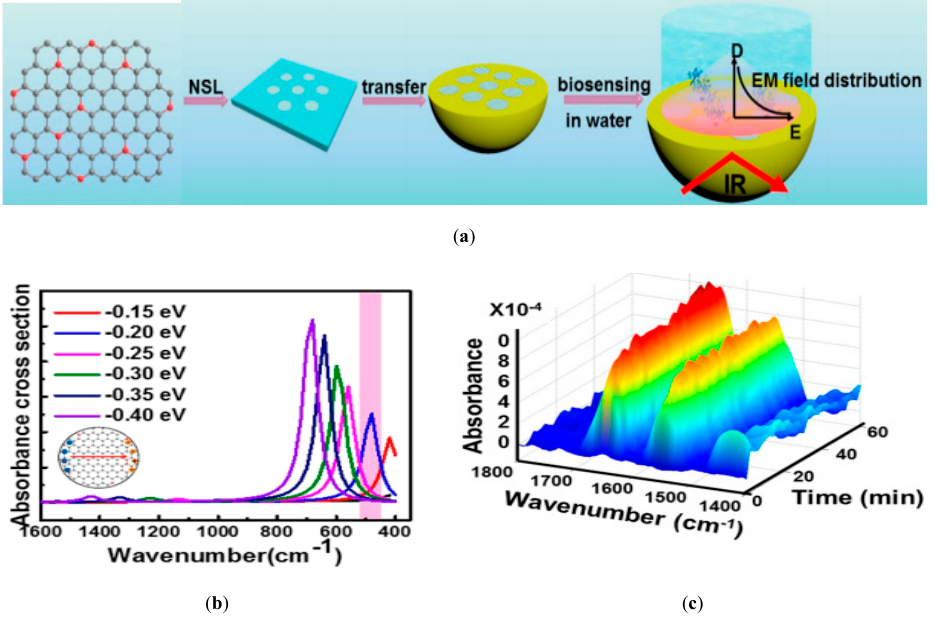
Figure 22. ( a) Schematic illustration of a graphene-based biosensor in the IR range; ( b ) Resonance tuning of the sensor with graphene Fermi energy tuning; ( c ) SEIRA spectra as a function of the immunoreaction of the boron-doped graphene nanodisk array. © 2018 American Chemical Society. Reprinted with permission from [307].